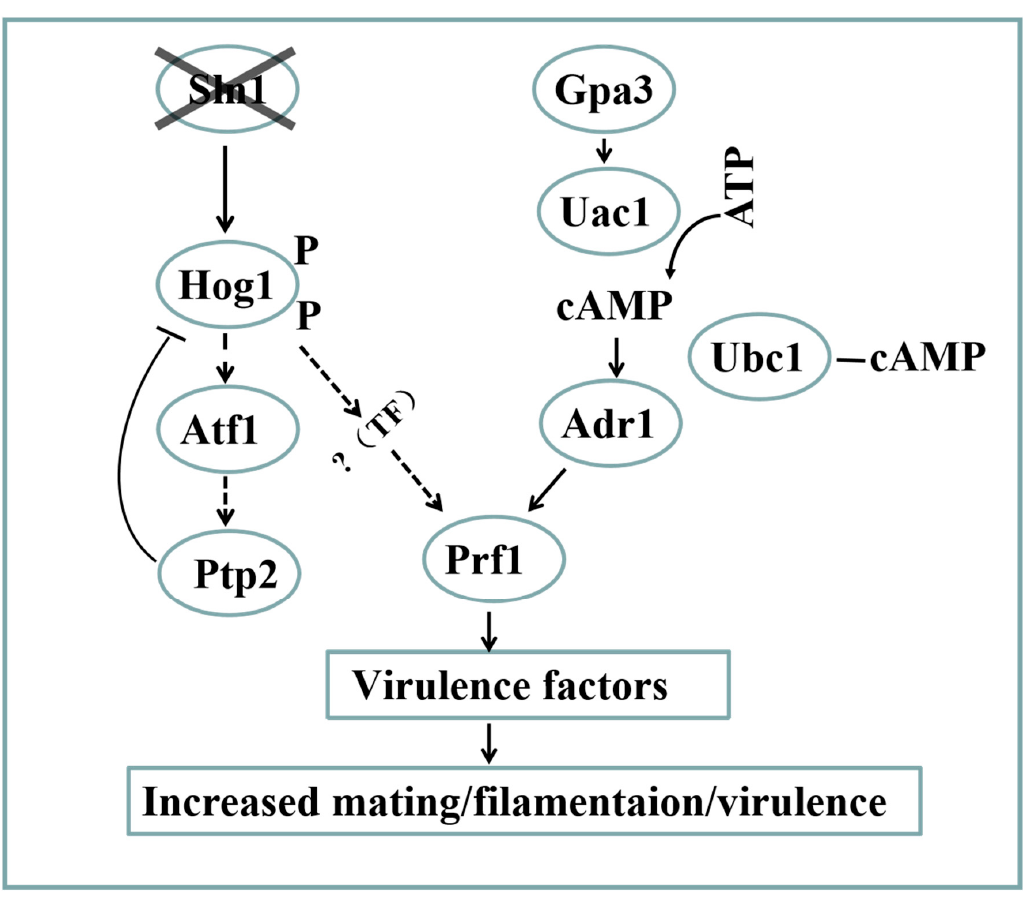
Figure 8. A proposed model depicting the outcomes after Sln1 loss in S. scitamineum . Loss of Sln1 results in increased phosphorylation of Hog1. The levels of Hog1 phosphorylation are suppressed via induction of the negative regulator Ptp2, which is initiated by the transcription factor Atf1. Loss of Sln1 function causes increased mating and virulence of S. scita- mineum , by possibly enhancing Hog1 activity to promote the transcription of Prf1. Furthermore, the cAMP/PKA signaling pathway positively regulates mating and virulence by the transcription factor Prf1. TF represents a transcription